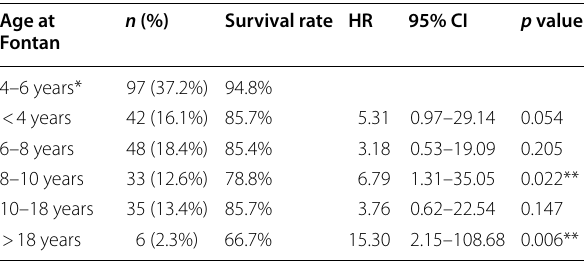
Table 4 Subgroup analysis of age at Fontan